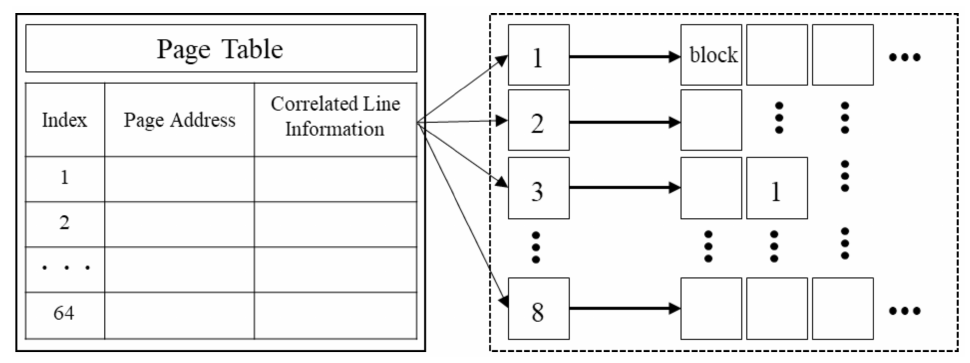
Figure 2. History